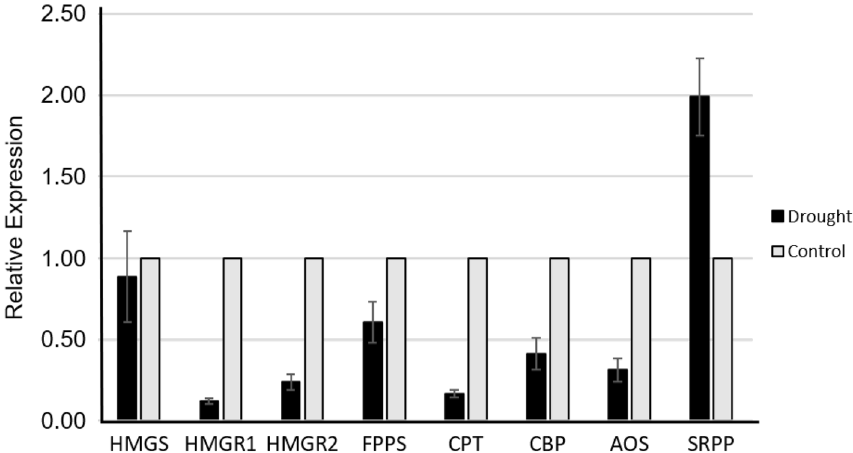
Figure 6. RT-PCR validation of expression levels. Selected guayule rubber biosynthesis related genes from stem tissues of plants grown under drought stress condition (black bars) relative to full irrigation control (grey bars). Values are the average of three biological replicates, error bars correspond to standard deviation